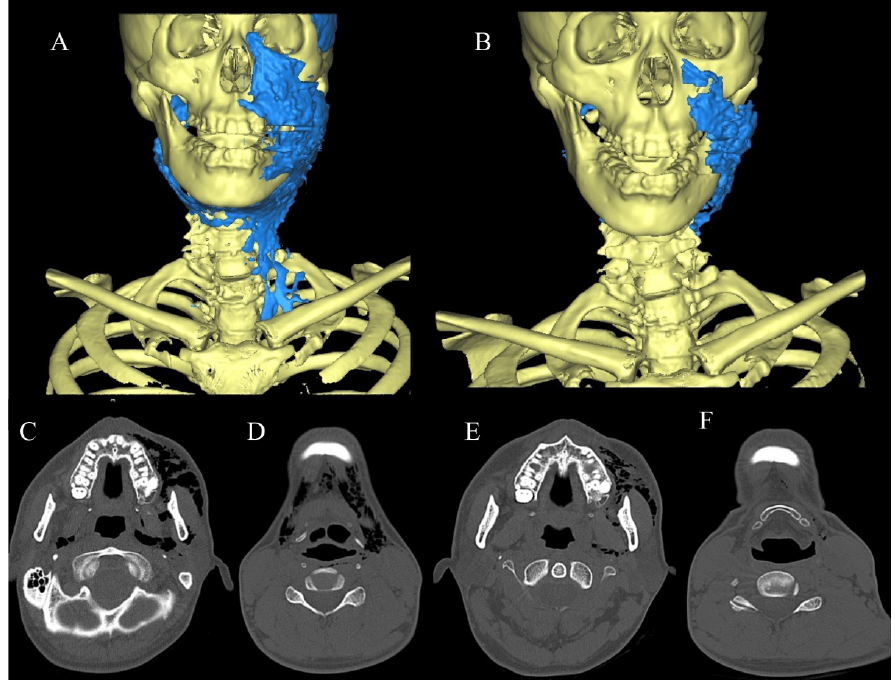
Figure 8. ( A ) 3D model based on CT at the first visit. The volume was measured at approximately 108 mL. ( B ) 3D model on the 3rd day after injury. The volume was approximately 24 mL. ( C , D ) CT at the first visit. ( E , F ) CT findings 2 days after injury. Table 1. CT at the first visit. The spread of emphysema to the tissue gap in cases 1–3 is shown sep- arately at the facial, cervical, and mediastinal levels; this shows the air volume in the 3D model on the initial visit and 3rd day after the injury.